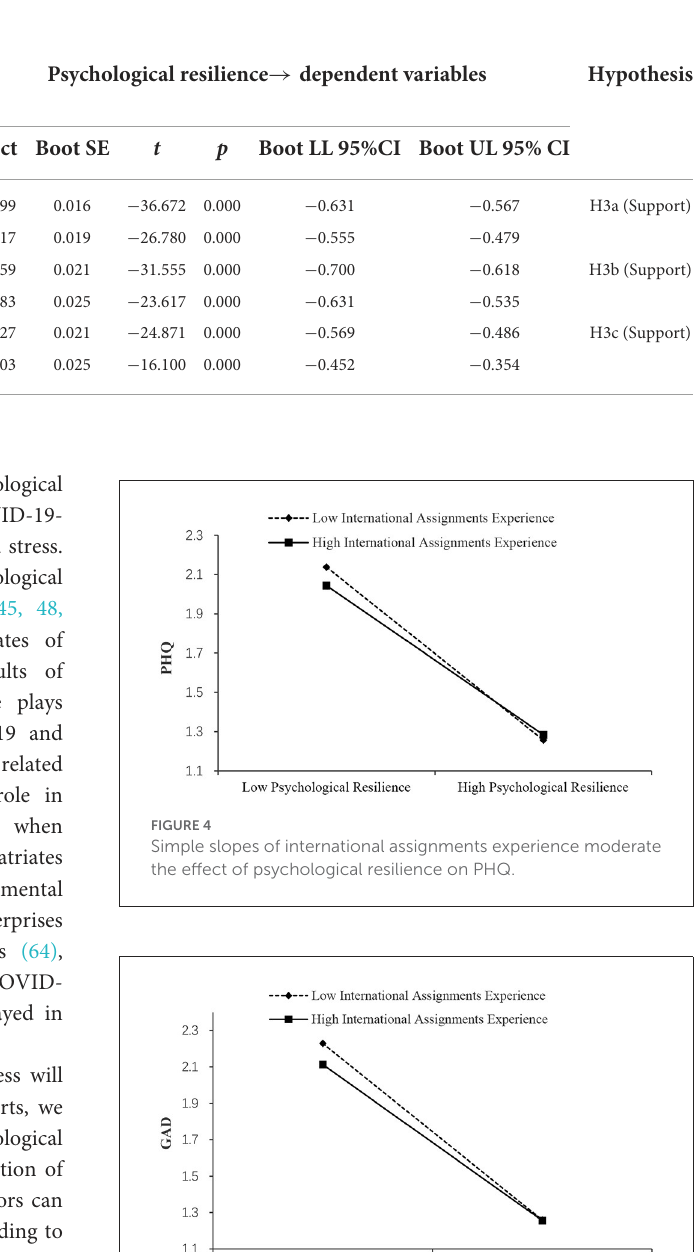
TABLE 7 Results of the moderated path analysis.